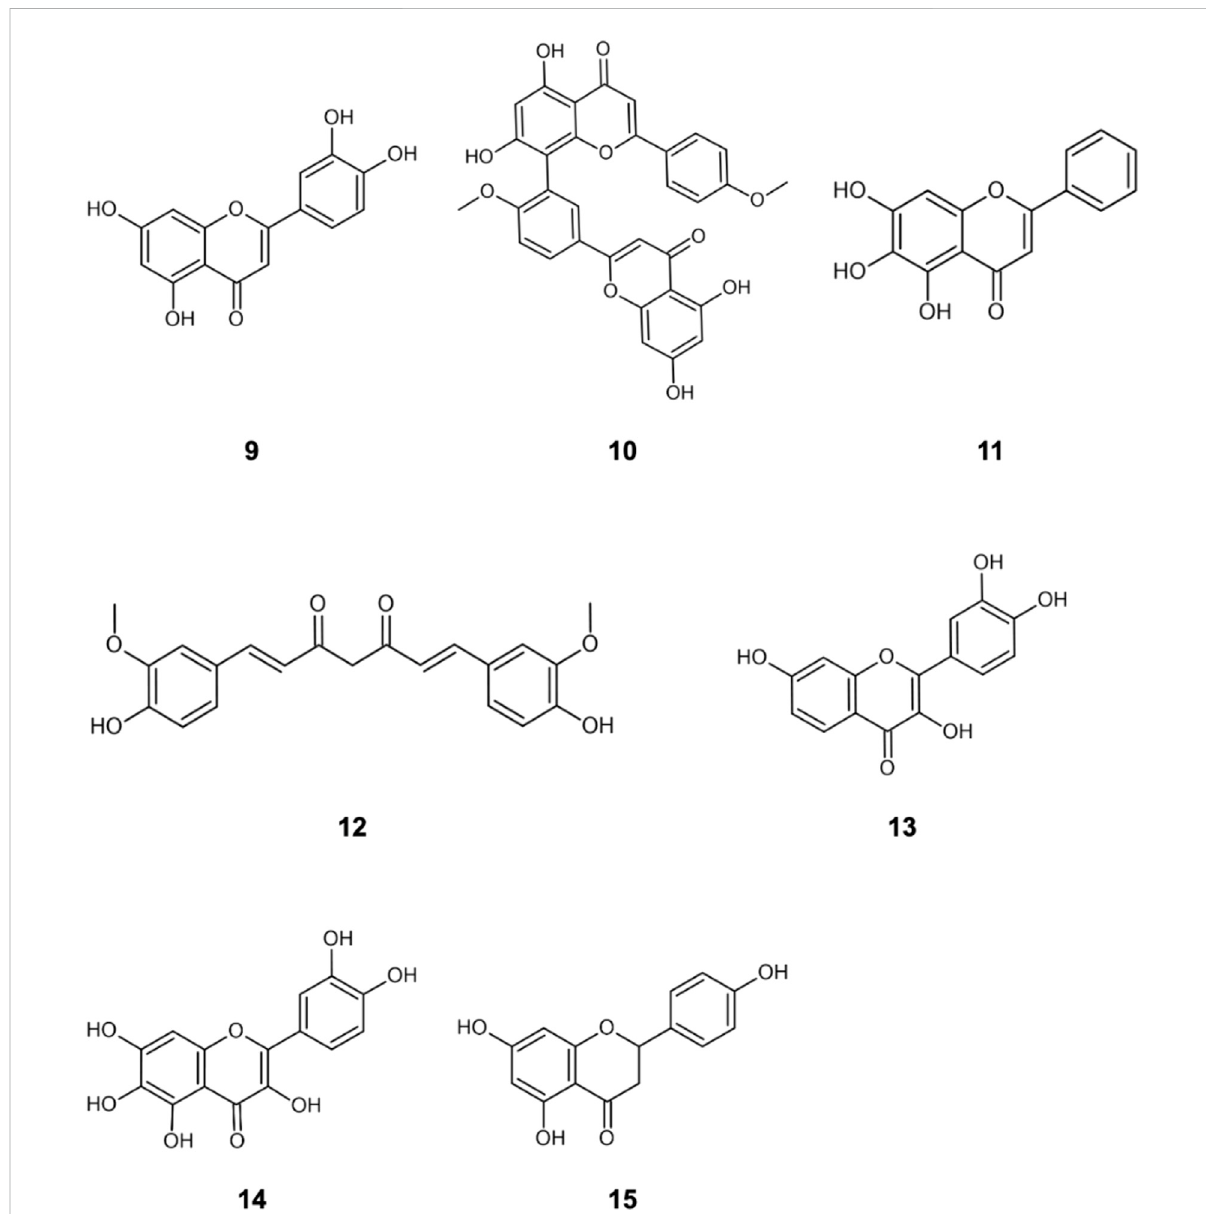
FIGURE 7 Additionallyreferencedpolyphenols:luteolin (9) ;Isoginkgetin (10) ;baicalein (11) ;curcumin (12) ; fi setin (13) ;quercetagetin (14); naringenin (15)